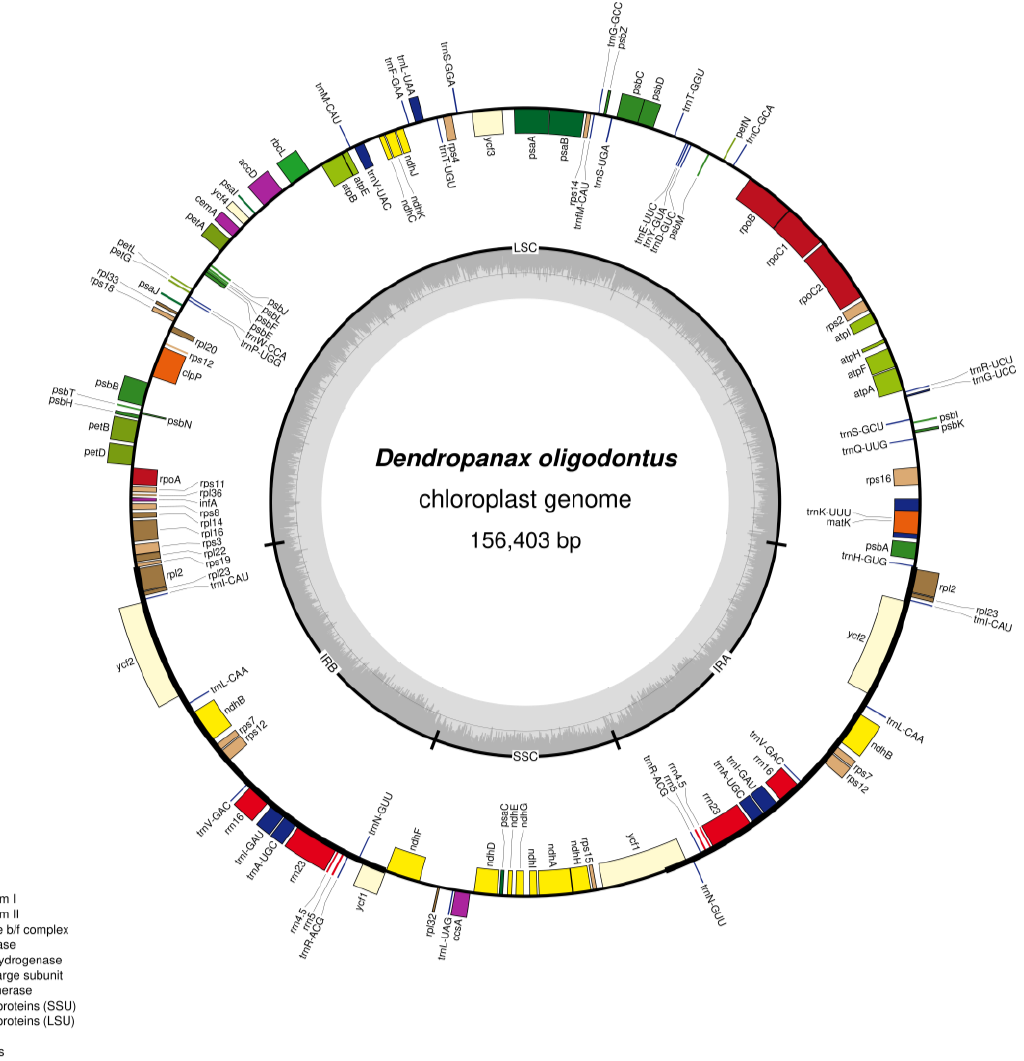
Figure 1. Gene map of the D. oligodontus chloroplast genome. Genes shown outside the outer circle are transcribed clockwise, and genes shown inside the circle are transcribed counter-clockwise. Genes belonging to different functional groups are colour-coded. The dashed area in the inner circle indicates the GC content of the chloroplast, and the light grey area corresponds to the AT content of the chloroplast.